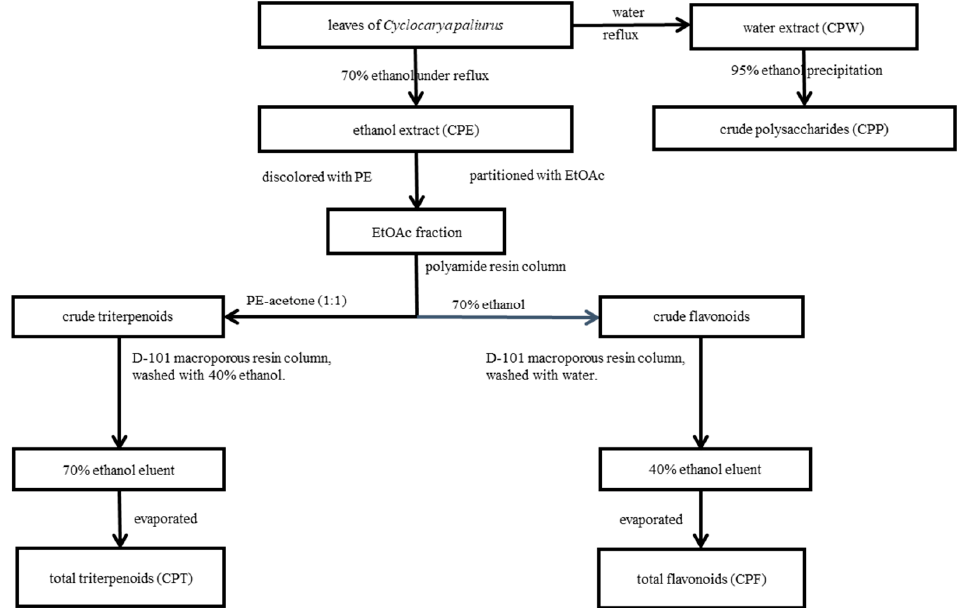
Figure 9. Extraction and purification procedures of C. paliurus leaves.